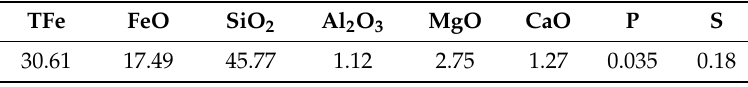
Table 1. Chemical compositions of studied iron ore sample (mass fraction, %).